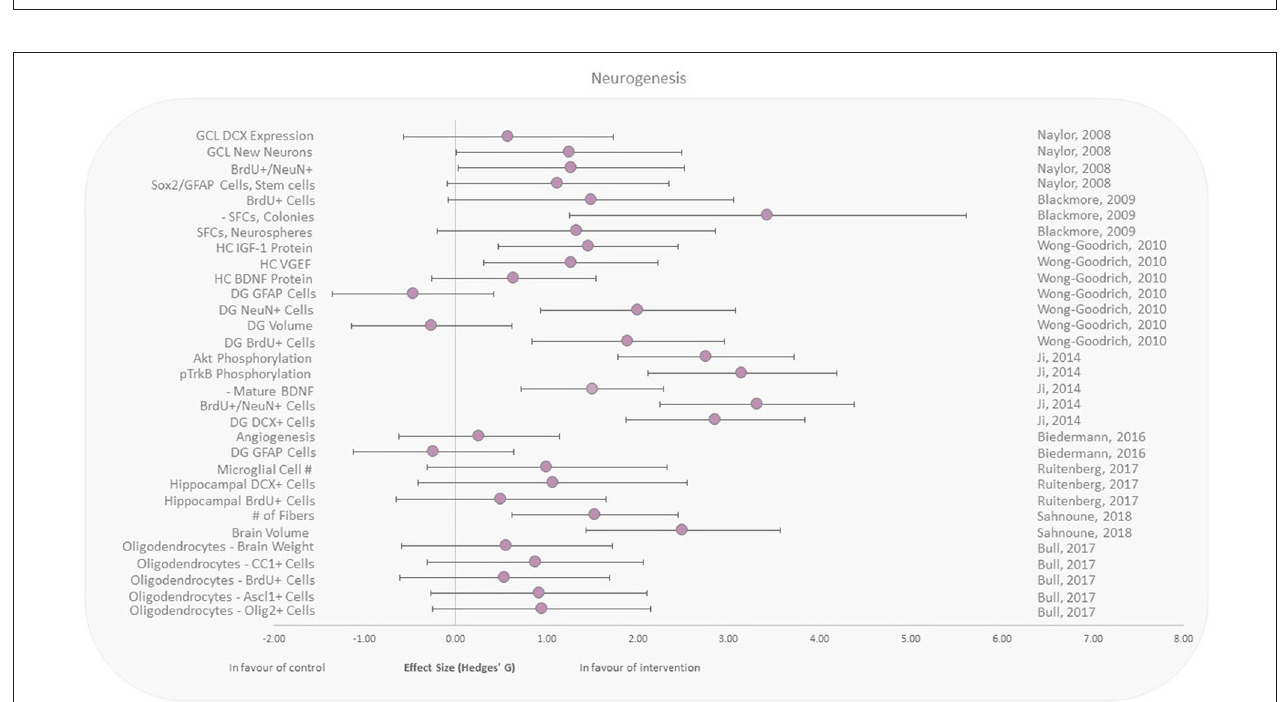
FIGURE 3 | Effect size plot of antioxidant activity, DNA damage, and inflammation. Outcomes are plotted with the Hedges’ g calculated for each outcome extracted and bias corrected for sample size. Confidence intervals of 95% are represented by the error bars. Effect size values that are in the positive rightward direction indicate a beneficial effect in favor of the exercise intervention group compared to the non-exercise control group. Shapes refer to the time at which the exercise intervention was applied with respect to the radiation exposure (Post—Circle, Pre—Square, During—Triangle).